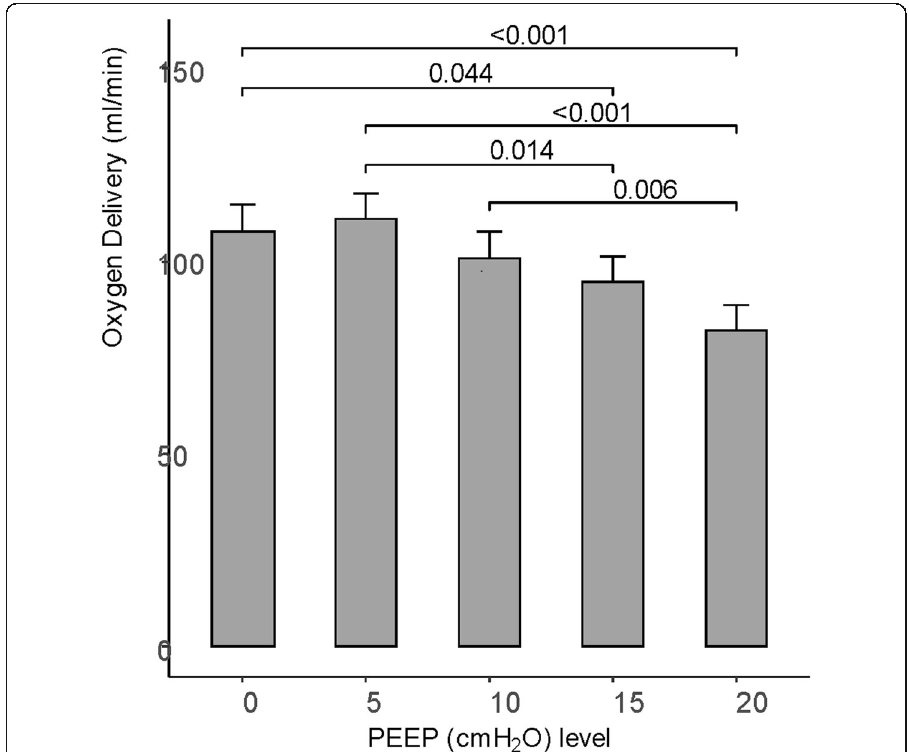
Fig. 2 Comparison of oxygen delivery for the different positive end-expiratory pressure (PEEP) levels during cardiopulmonary